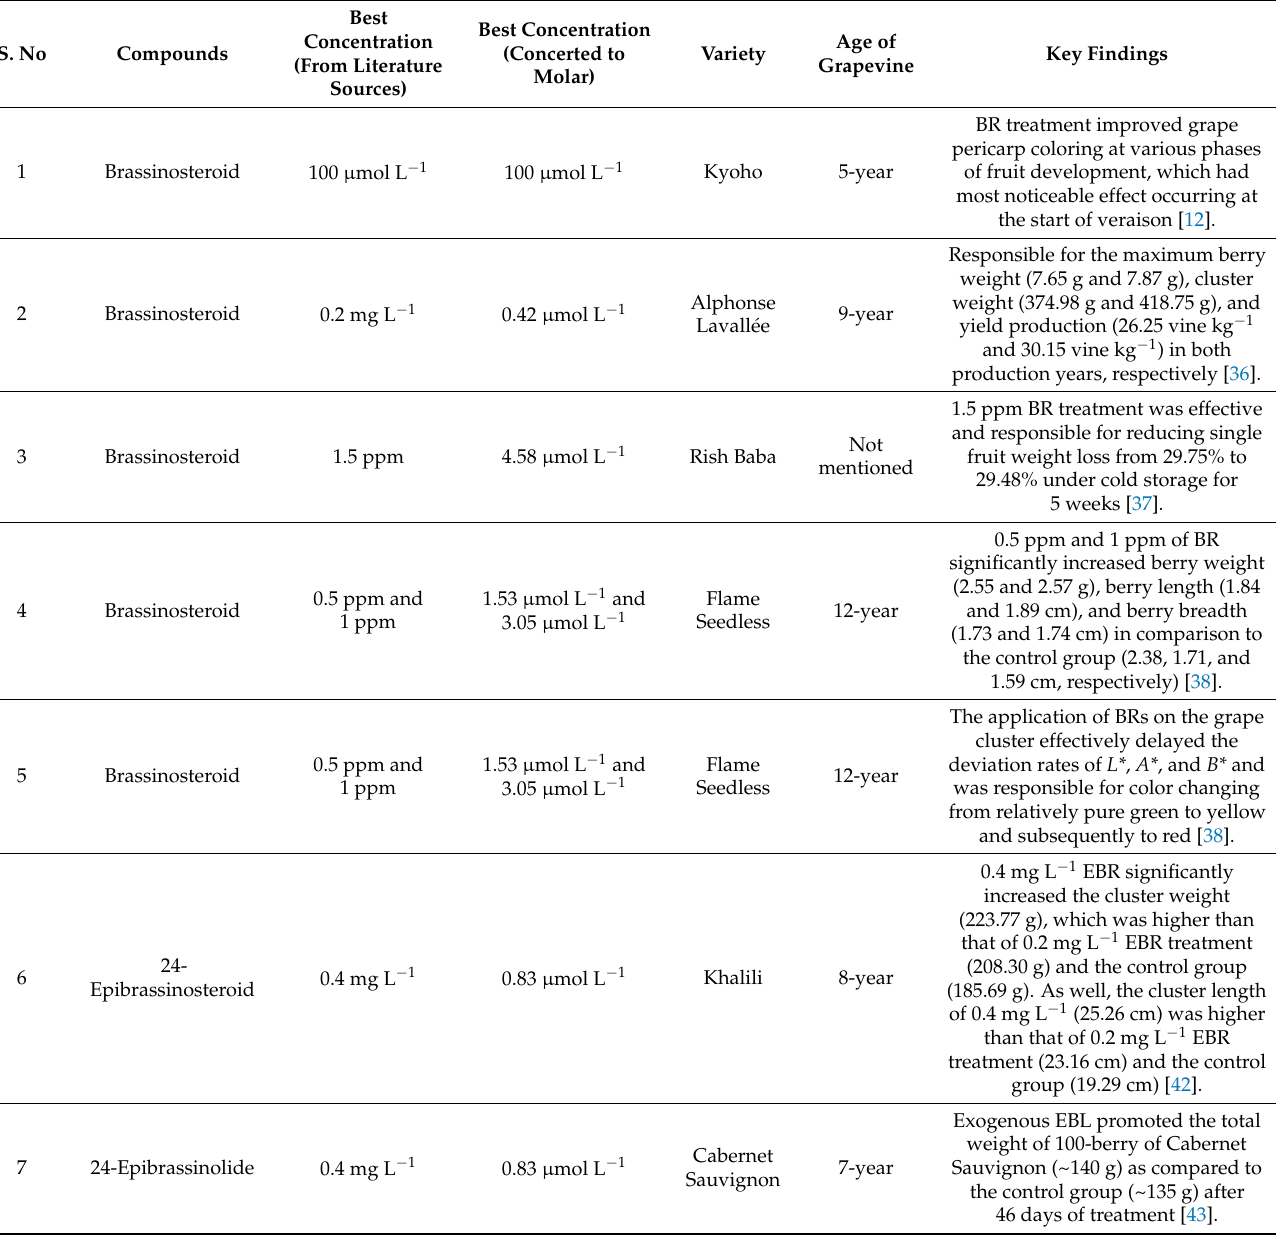
Table 1. Role of exogenous brassinosteroid/brassinolide on the growth or development of external grape berries